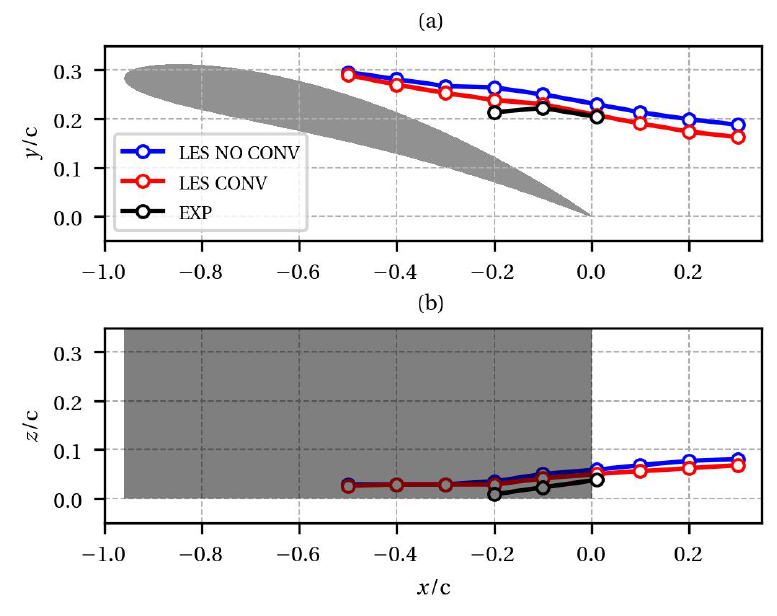
Figure 8. Projected mean trajectory of the tip leakage vortex on planes xOy ( a ) and xOz ( b